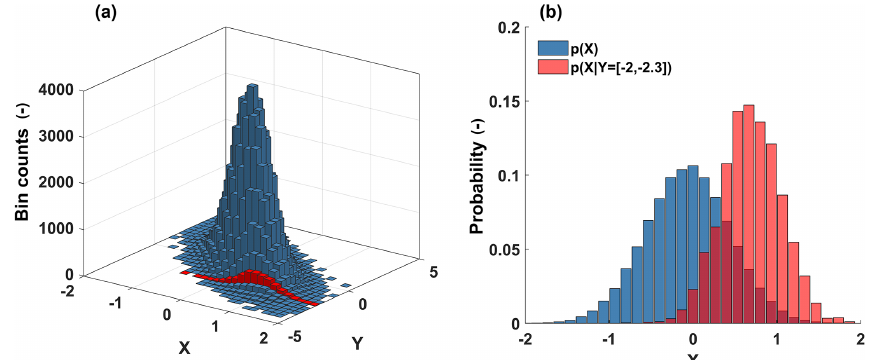
Figure 1. Illustration of a bivariate conditional probability distribution as a simple data-based predictive model. (a) Joint histogram of target X and predictor Y (blue). Conditional histogram of target X given predictor values from the interval [ − 2, − 2 . 3] (red). (b) Marginal (unconditional) probability distribution of target X (blue) and conditional probability distribution of target X given predictor values from the interval [ − 2, − 2 . 3]